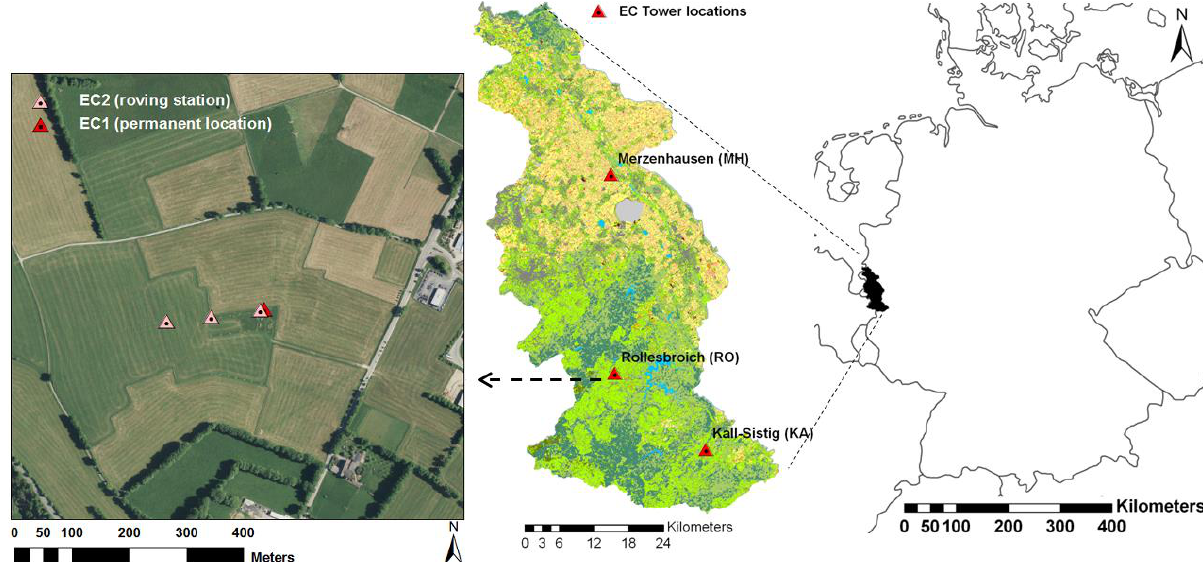
Figure 1. Eddy covariance (EC) tower locations in the Rur Catchment (center) including the Rollesbroich test site (left).